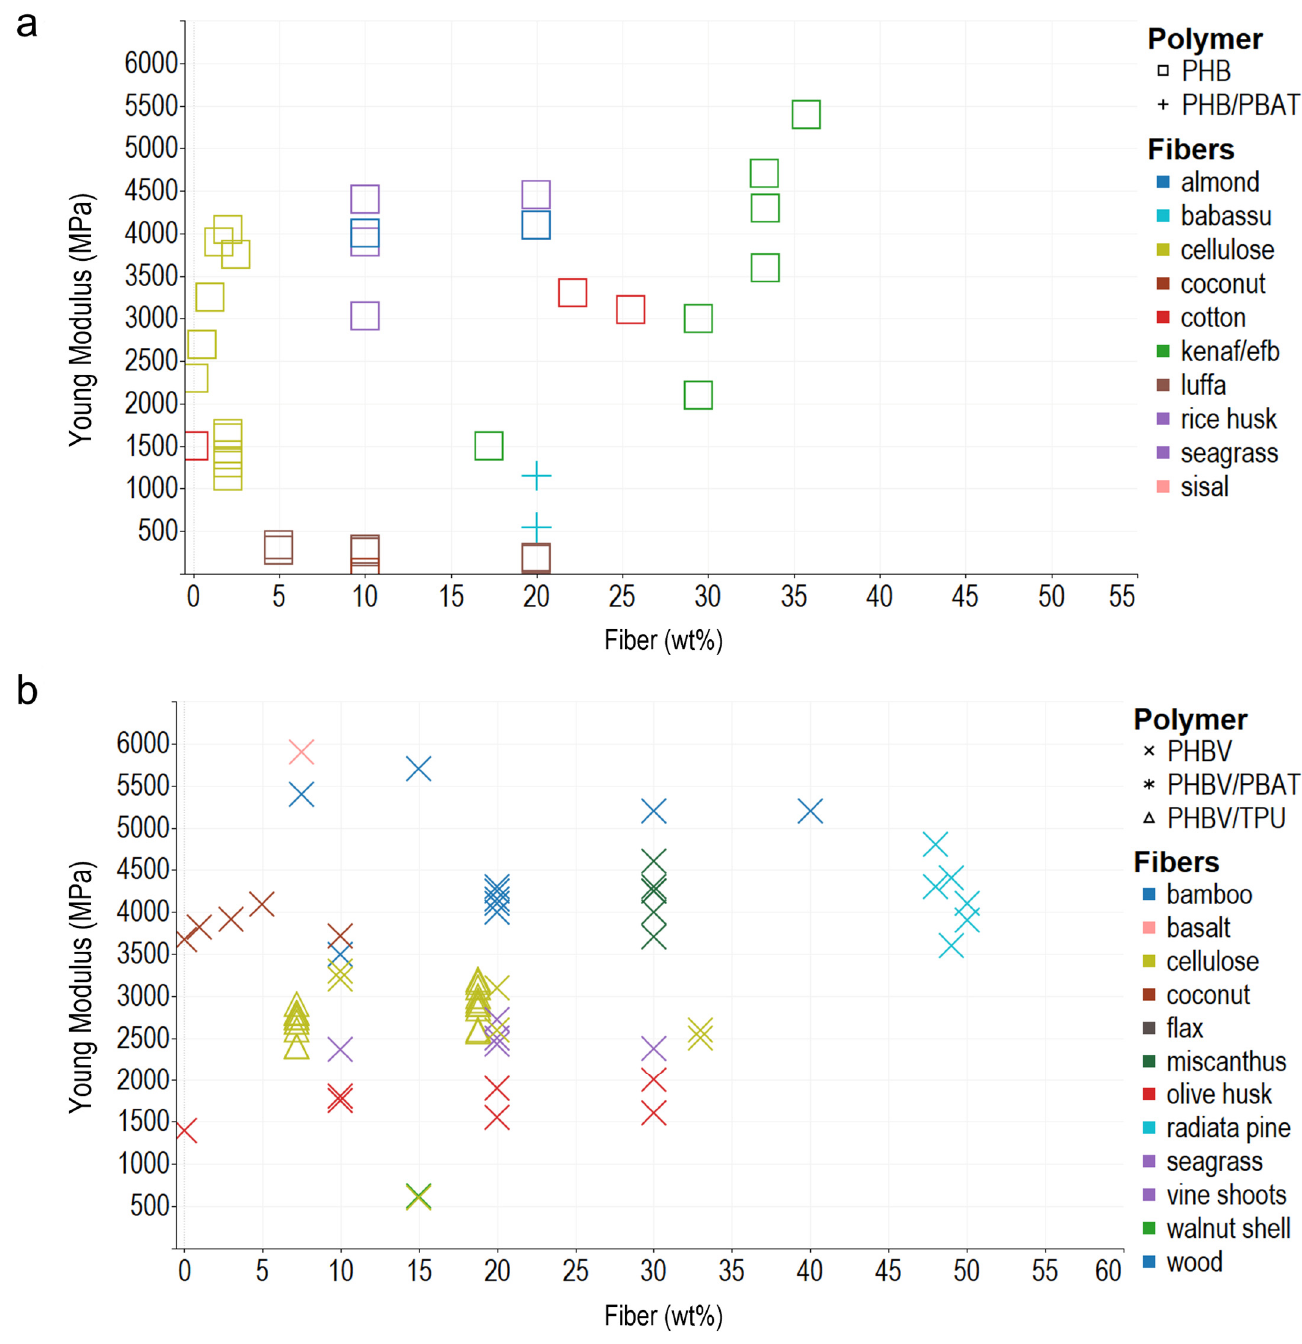
Figure 1. Young modulus of different PHA–fiber composites. ( a ) PHB and PHB/PBAT blends. ( b ) PHBV and its blends with PBAT and TPU. The colors refer to the fiber type (fillers), and the shapes refer to polymer types (matrix ).